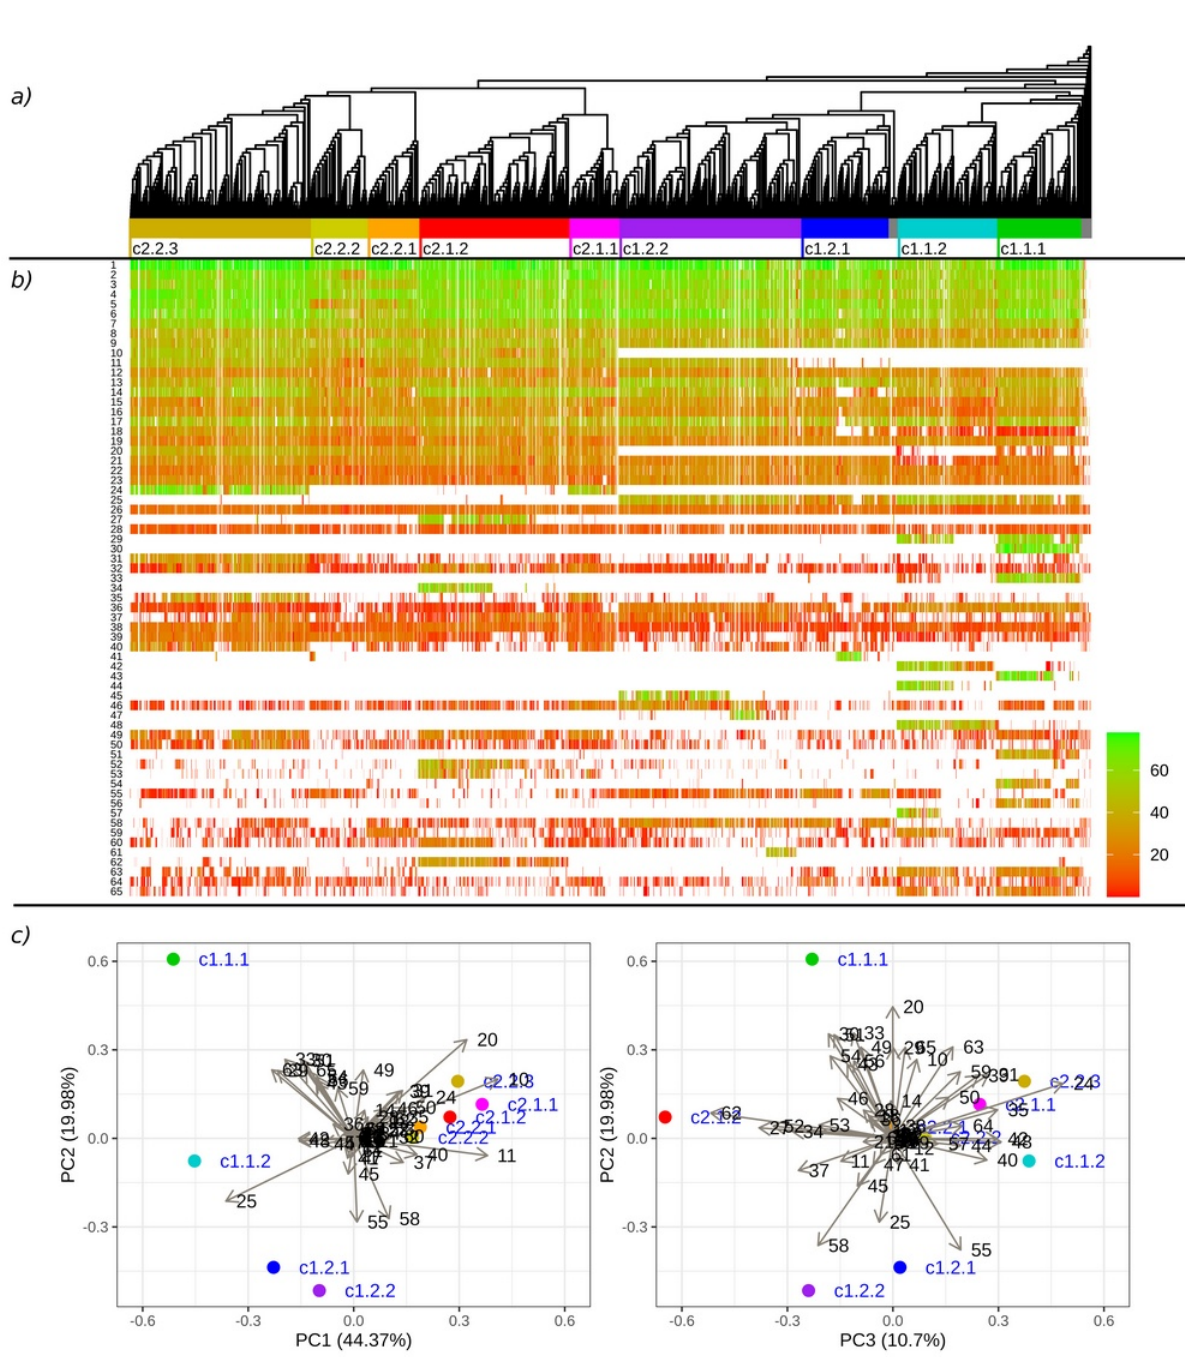
Figure 2. The results of the phylogenetic analysis and MEME motif search of the 4886 MLO proteins: ( a ) The neighbour-joining tree of MLO proteins; ( b ) the occurrence of the selected motifs across the MLO proteins, with colours indicating the motif matching scores; ( c ) a principal component analysis of the frequency of the motif occurrences in the defined phylogenetic clades. The motif numeration is in accordance with the MEME results in the Supplementary Material (File S2).